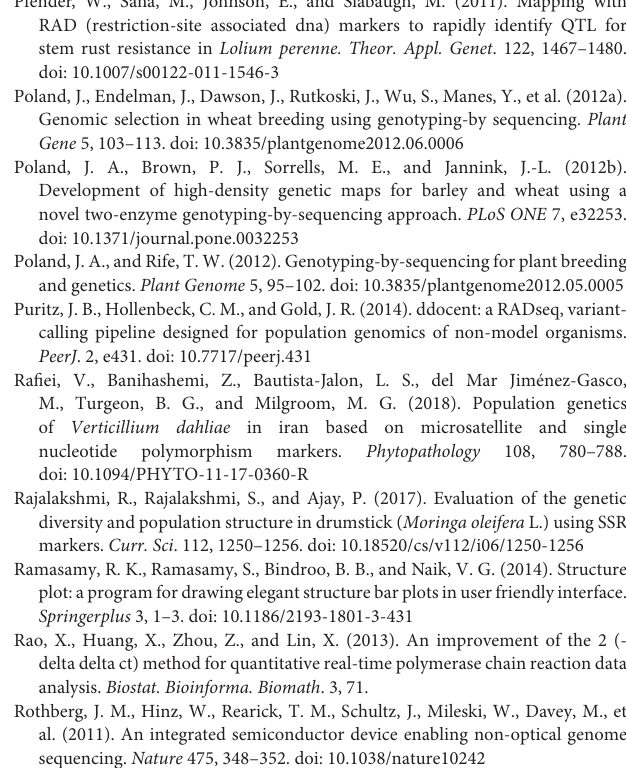
plot:aprogramfordrawingelegantstructurebarplotsinuserfriendlyinterface. Springerplus 3, 1–3. doi: